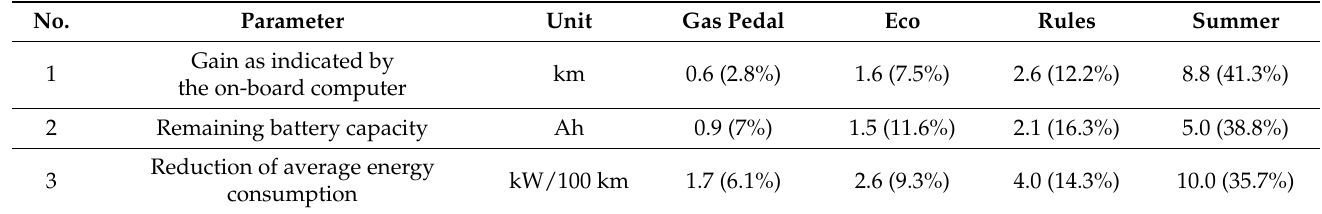
Table 5. Average values of the test run parameters in relation to the normal driving mode.